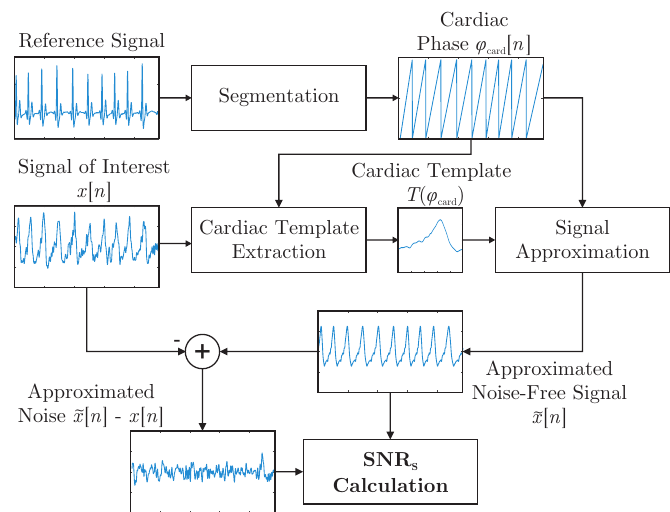
Figure 4. Overview of the SNR S approach. Note that T card ( ϕ card ) is obtained during an artifact-free episode of x [ n ] (visualized here). Once obtained, it can be used to analyze the signal of interest anytime a reference segmentation is available (see also Figure